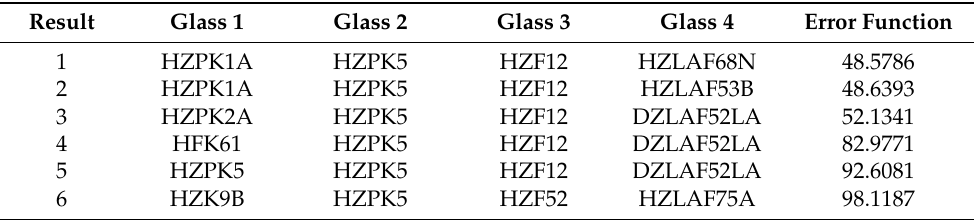
Table 6. Glass selection and error functions of conventional athermalization results.